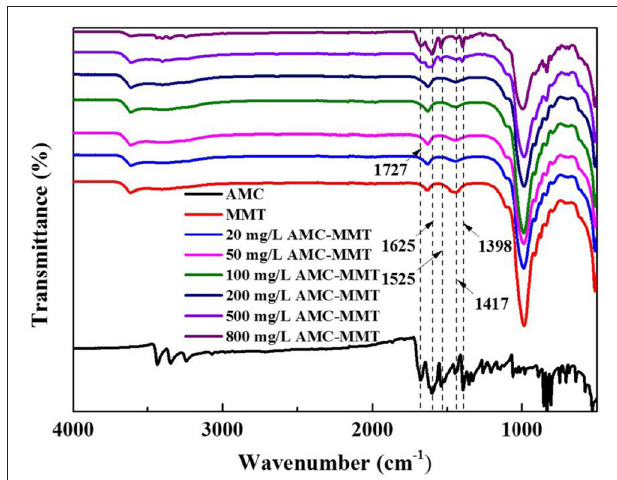
FIGURE 3 | FTIR spectra of AMC, and MMT with different amounts of AMC adsorption.